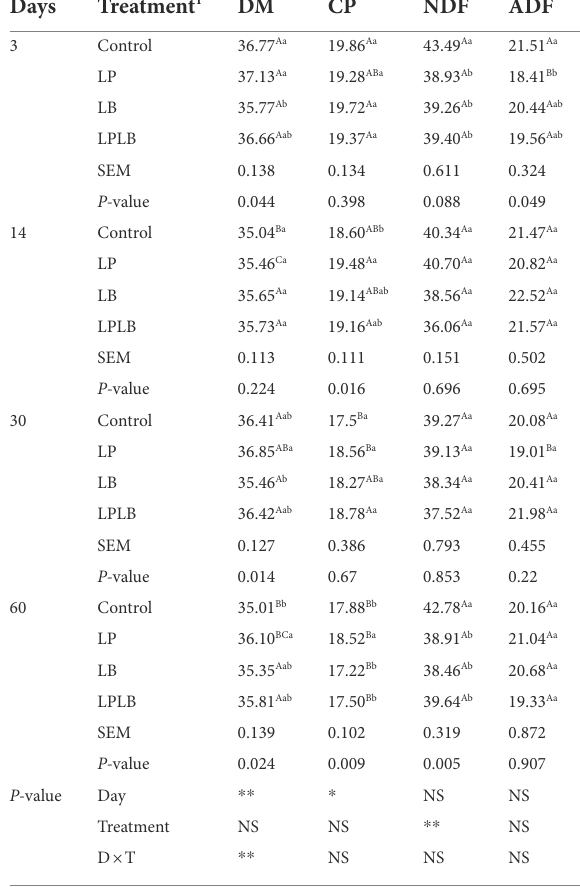
TABLE 1 Effects of Lactiplantibacillus plantarum and Lactiplantibacillus brevis on chemical compositions of paper mulberry